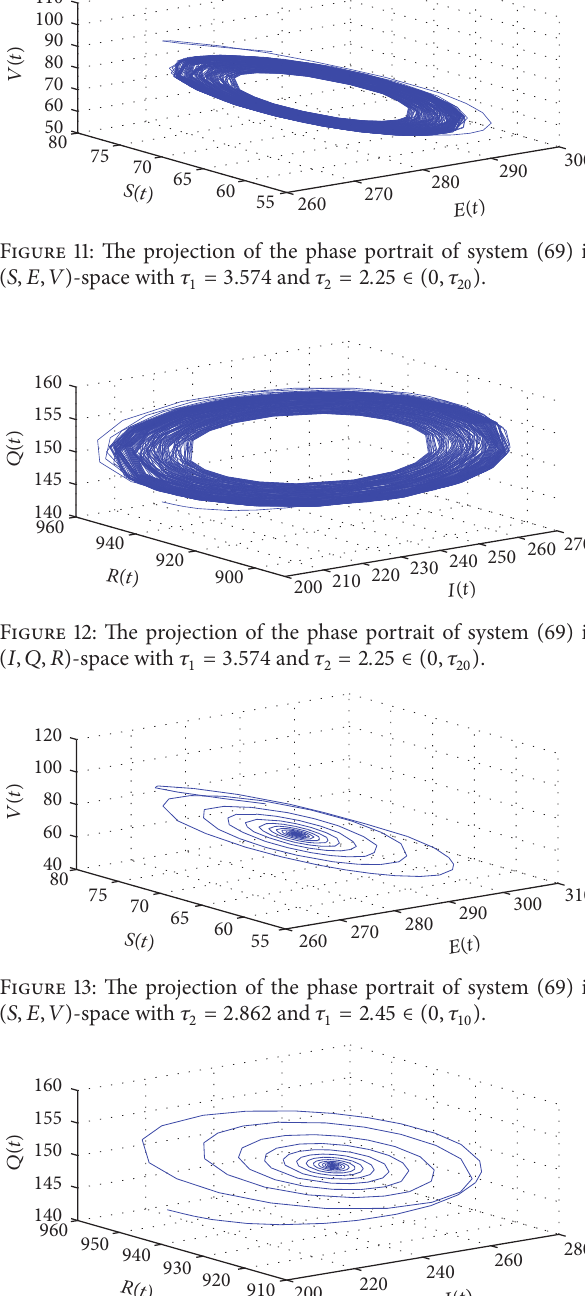
Figure 14: The projection of the phase portrait of system (69) in (𝐼, 𝑄, 𝑅) -space with 𝜏